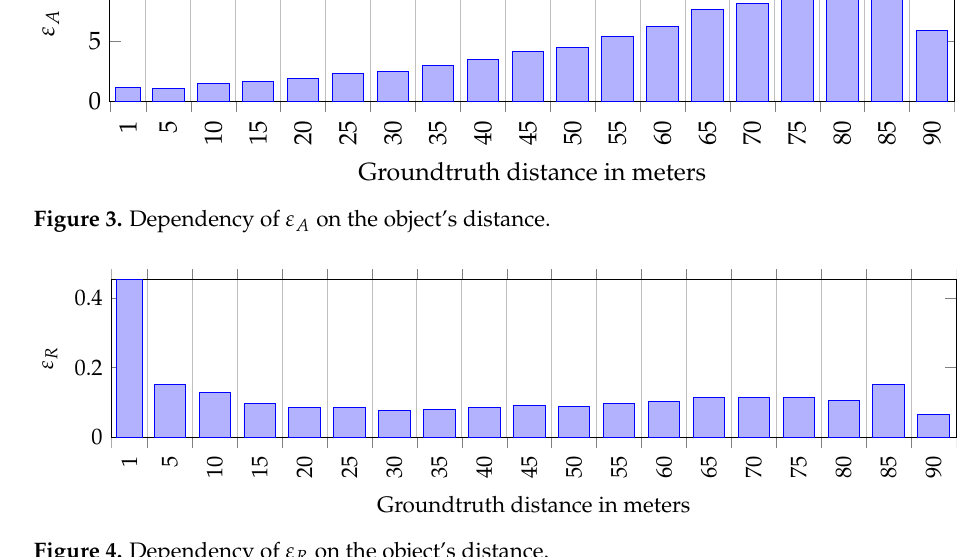
Figure 4. Dependency of ε R on the object’s distance.